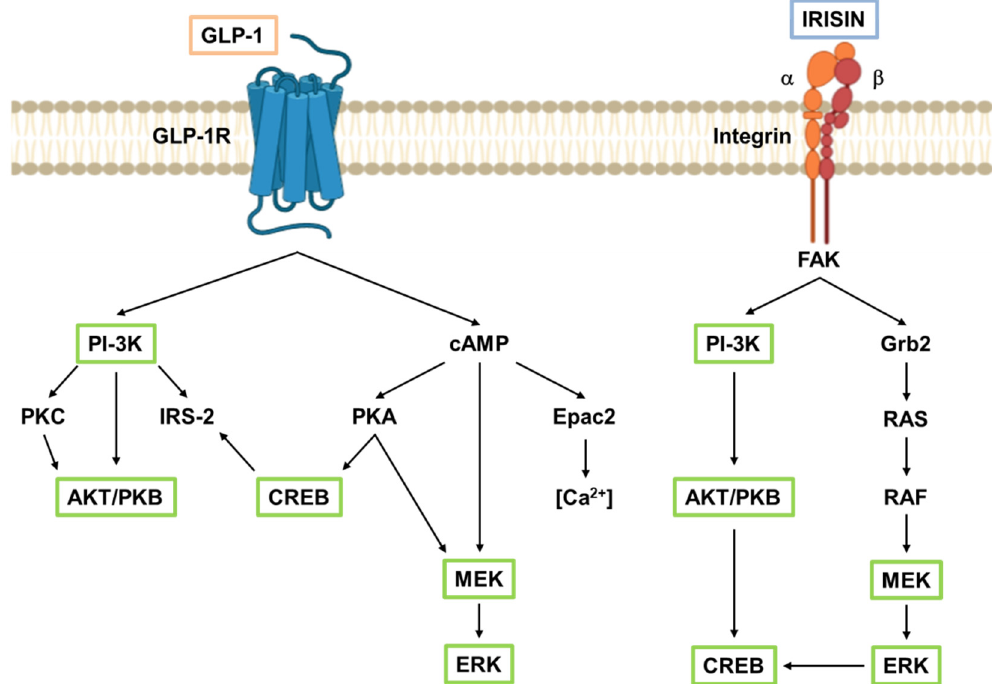
Figure 2. Main GLP-1R and integrin signaling pathways. GLP-1R and integrins, although structurally very different, share numerous intracellular signaling mediators (green boxes), ultimately leading to cell growth and survival. AKT/PKB, protein kinase B; cAMP, cyclic adenosine monophosphate; CREB, cAMP response element-binding protein; Epac2, exchange protein activated by cAMP 2; ERK, extracellular signal-regulated kinases; FAK, focal adhesion kinase; GLP-1, glucagon-like peptide-1; GLP-1R, glucagon-like peptide-1 receptor; Grb2, growth factor receptor-bound protein 2; IRS-2, insulin receptor substrate 2; MEK, mitogen-activated protein kinase; PI-3K, phospatidylinositol-3 kinase; PKA, protein kinase A; PKC, protein kinase C; RAF, rapidly accelerated fibrosarcoma; RAS, rat sarcoma.